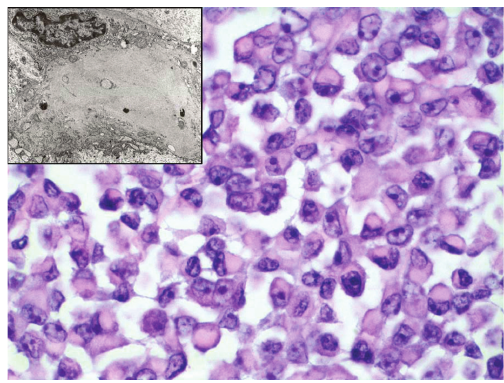
Figure 2: Rhabdoid cells grow in loosely cohesive sheets. The cells are rounded to ovoid, have rounded nuclei with prominent nucle- oli; homogeneous, deeply, eosinophilic hyaline cytoplasmic inclu- sions displace the nucleus laterally (hematoxylin and eosin stain, X 600). A magnified part by electron microscopy shows that paranu- clear spherical aggregates of intermediate filaments displace most organelles and the nucleus. No tonofilaments are present (original magnification is X